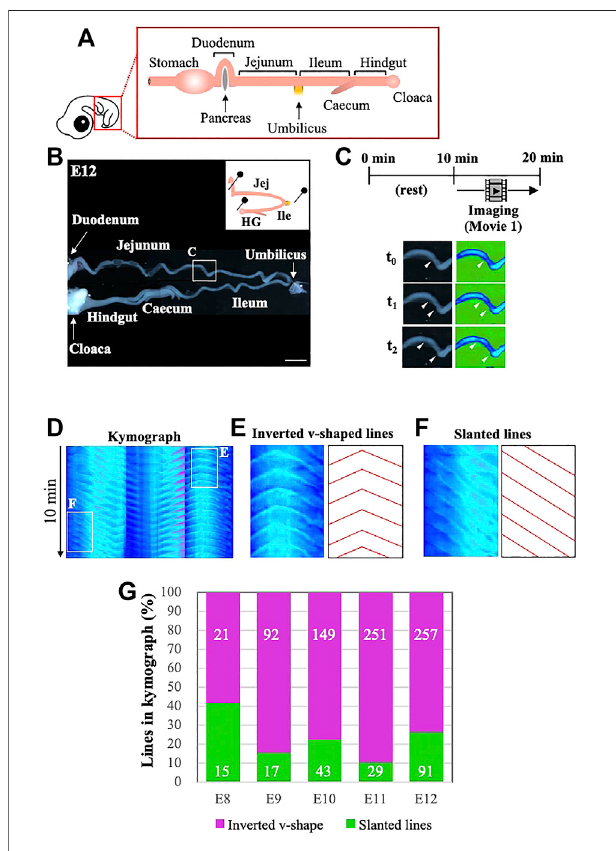
FIGURE 1 | Kymography reveals that bidirectional waves are predominant in embryonic gut peristalsis, at least until E12. (A) The segment ofgutlocatedposteriorlytothestomachisdissected fromanembryo,and (B) placed into a Petri dish with gentle holding with pins to avoid dislocation of the specimen. (C) The specimen is video recorded for 10 min following 10 min of rest in a dish, and subsequently subjected to digital processing with ImageJ so that peristaltic movements can be visualized by changes in colors. The photos, showing an origin and the propagating waves, are three frames extractedfrom Supplementary VideoS1 at theportion indicatedinasquare in B. (D) Digital images are further processed to make kymographs. Periodic propagation of peristaltic waves is represented by repeated lines along the time period of 10 min (E, F) If the propagation of a wave is bidirectional which is accompanied by an origin, it is shown in the kymograph as an inverted v-shape with an apex (E) , whereas unidirectionally propagating waves are represented simply by slanted lines without an apex (F) . (G) The majority of peristalticwavesarebidirectional inembryonicgutsexaminedfromE8toE12. Scale bar: 4